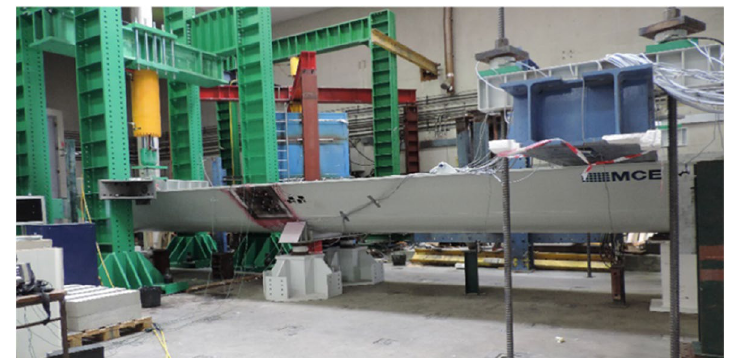
Fig. 12 Steel box girder with curved stiffened plates at the